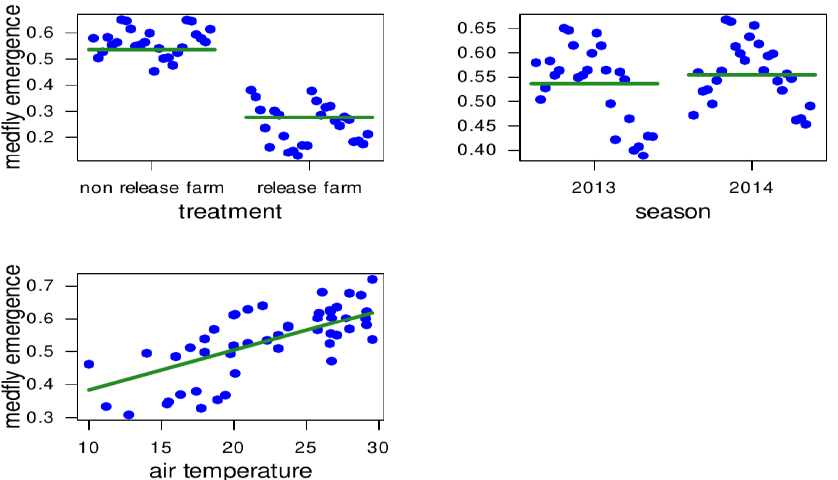
Figure 3. Direct influences of treatment (non-parasitoid release farm (CF) and parasitoid ( Diachasmi- morpha longicaudata ) release farm (TF)), study season (years 2013 and 2014), and air temperature on medfly ( Ceratitis capitata ) emergence (proportion of emerged medfly adults) on two experimental fruit farms in San Juan, central–western Argentina. The fitted green central line depicts partial regression from the GLS model applied to averaged values by period, while the blue points are the observed ones. The partial residuals show that the magnitude of medfly emergence on the parasitoid release farm is almost half that of medfly emergence in the non-parasitoid release farm. The distribution patterns of the errors within each group denote the time-structured variation within each season, that is, variation due to differences between groups within a season. The temperature has a positive effect on medfly emergence.